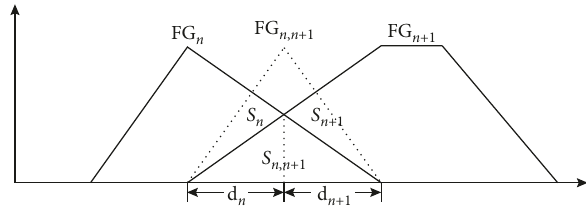
Figure 4: Fuzzy intersection reliability